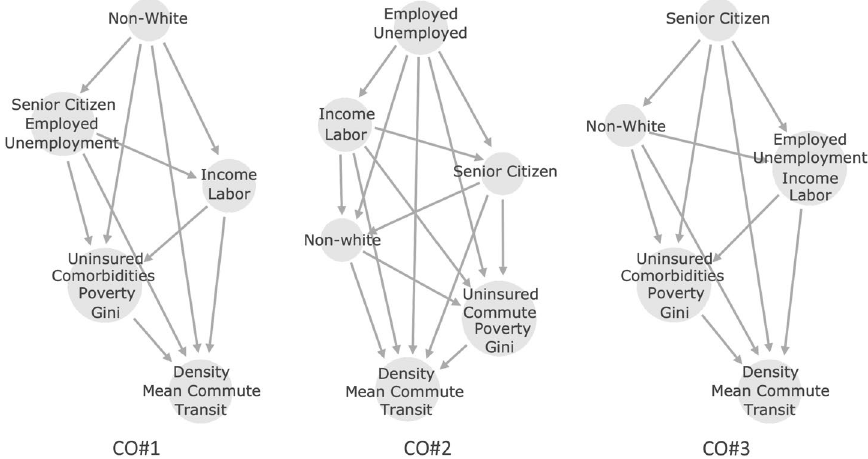
Figure 1. The three primary partial causal ordering that we consider in this